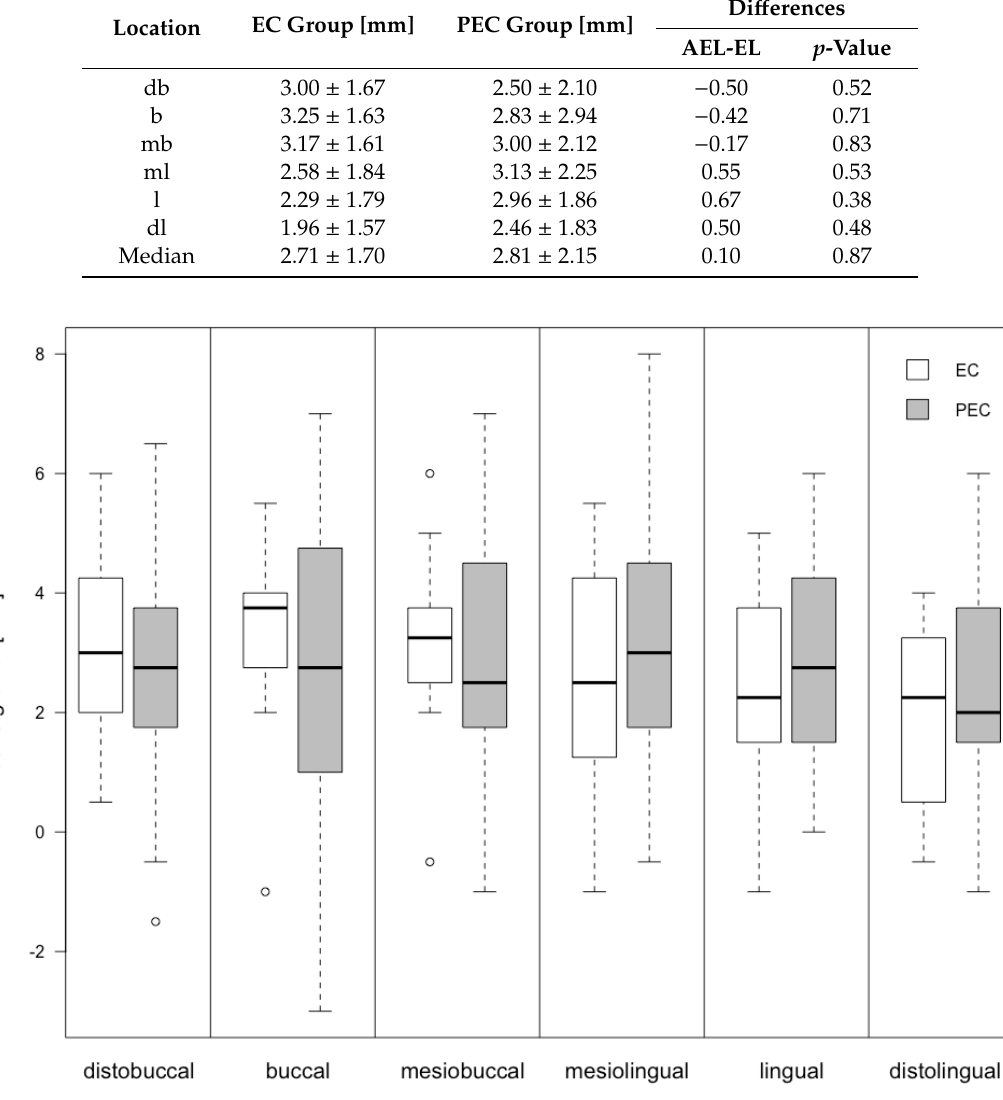
226 Table 2. Bone gain and di ff erences between EC and AFL group. Table 2. Bone gain and differences between EC and AFL group.